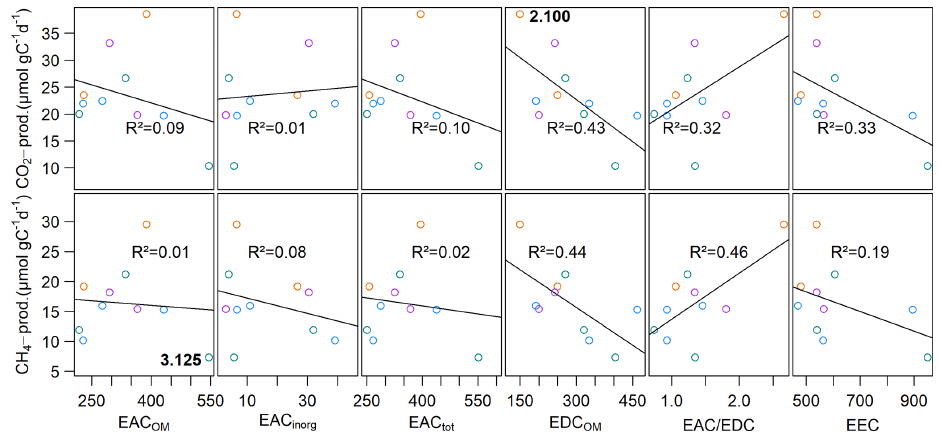
Figure 7. Linear regression of CH 4 and CO 2 production rates with the initial EAC and EDC. Points are mean values of triplicate mea- surements at each site. At site 2.100, the highest CO 2 production rate concurred with lowest EDC OM , and at site 3.125, the lowest CH 4 production rate concurred with the highest EAC OM . Different colors denote different depth categories (see Fig. 4). Table 4. Spearman’s rank correlation coefficients for CH 4 and CO 2 fluxes (means of each intact sediment core incubation except for corre- lations with sediment stock changes for which values from each sampling date were used) and different sediment characteristics; n.s. means that correlations were not significant ( p> 0 .